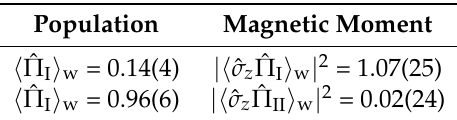
Table 1. Final results of weak